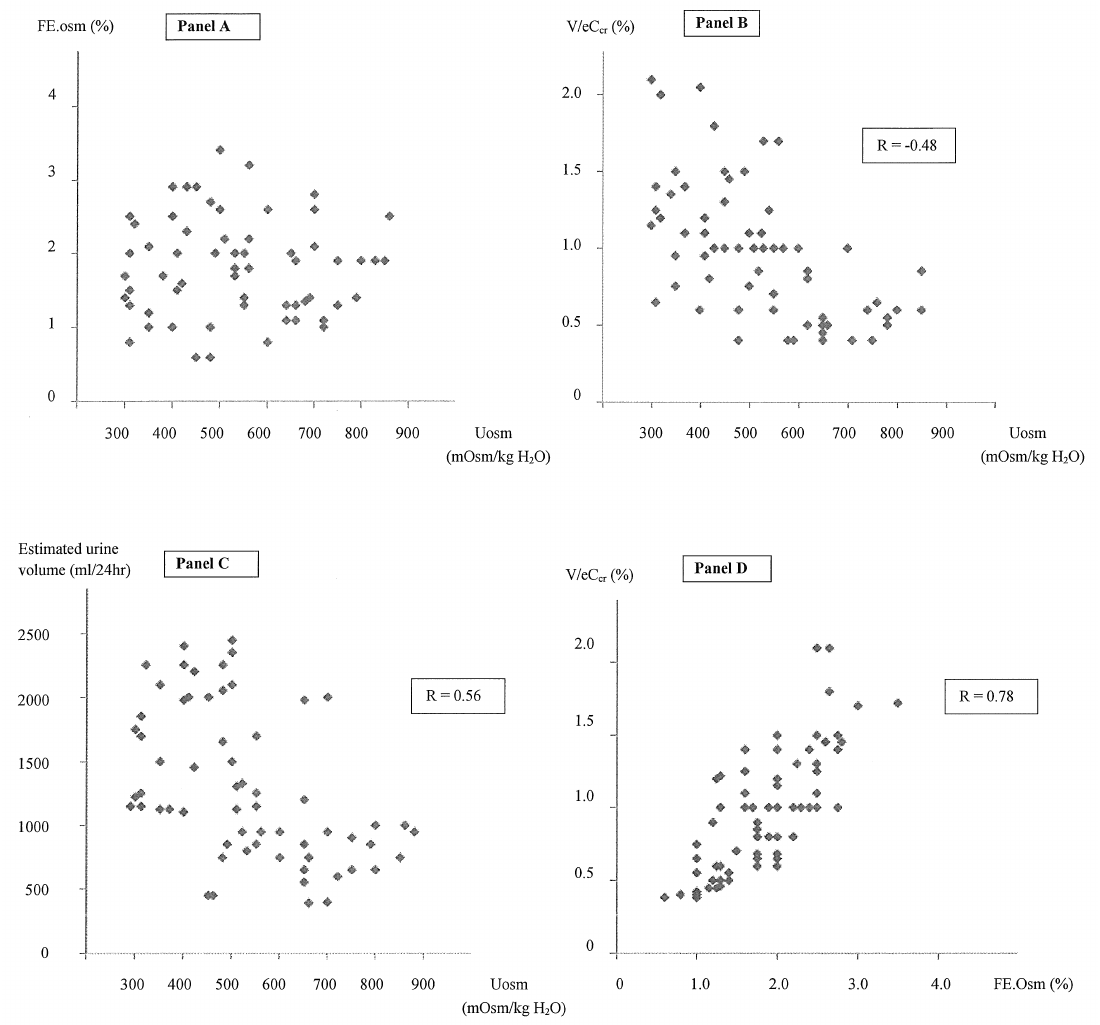
Figure 1. Panel 1A-Lack of correlation between Uosmolality and FE.Osm. Panel 1B-Mild correlation between urine osmolality and V / cCcr (%) ( r = 0.48; p < 0.001). Panel 1C-Correlation between urine osmolality and estimated urine volume ( r = 0.56, p < 0.001). Panel 1D-High correlation between FE.Osm Figure 1 : Panel 1A – Lack of correlation between Uosmolality and FE.osm. Panel 1B and V / eCcr (%) ( r = 0.78; p < 0.001). – Mild correlation between urine osmolality and V/cCcr (%) (r = 0.48; p< 0.001). Panel 1C – Correlation between urine osmolality and estimated urine volume (r = 0.56, p< 0.001). Panel 1D – High correlation between FE.osm and V/eCcr (%) (r = 0.78; p< 0.001).